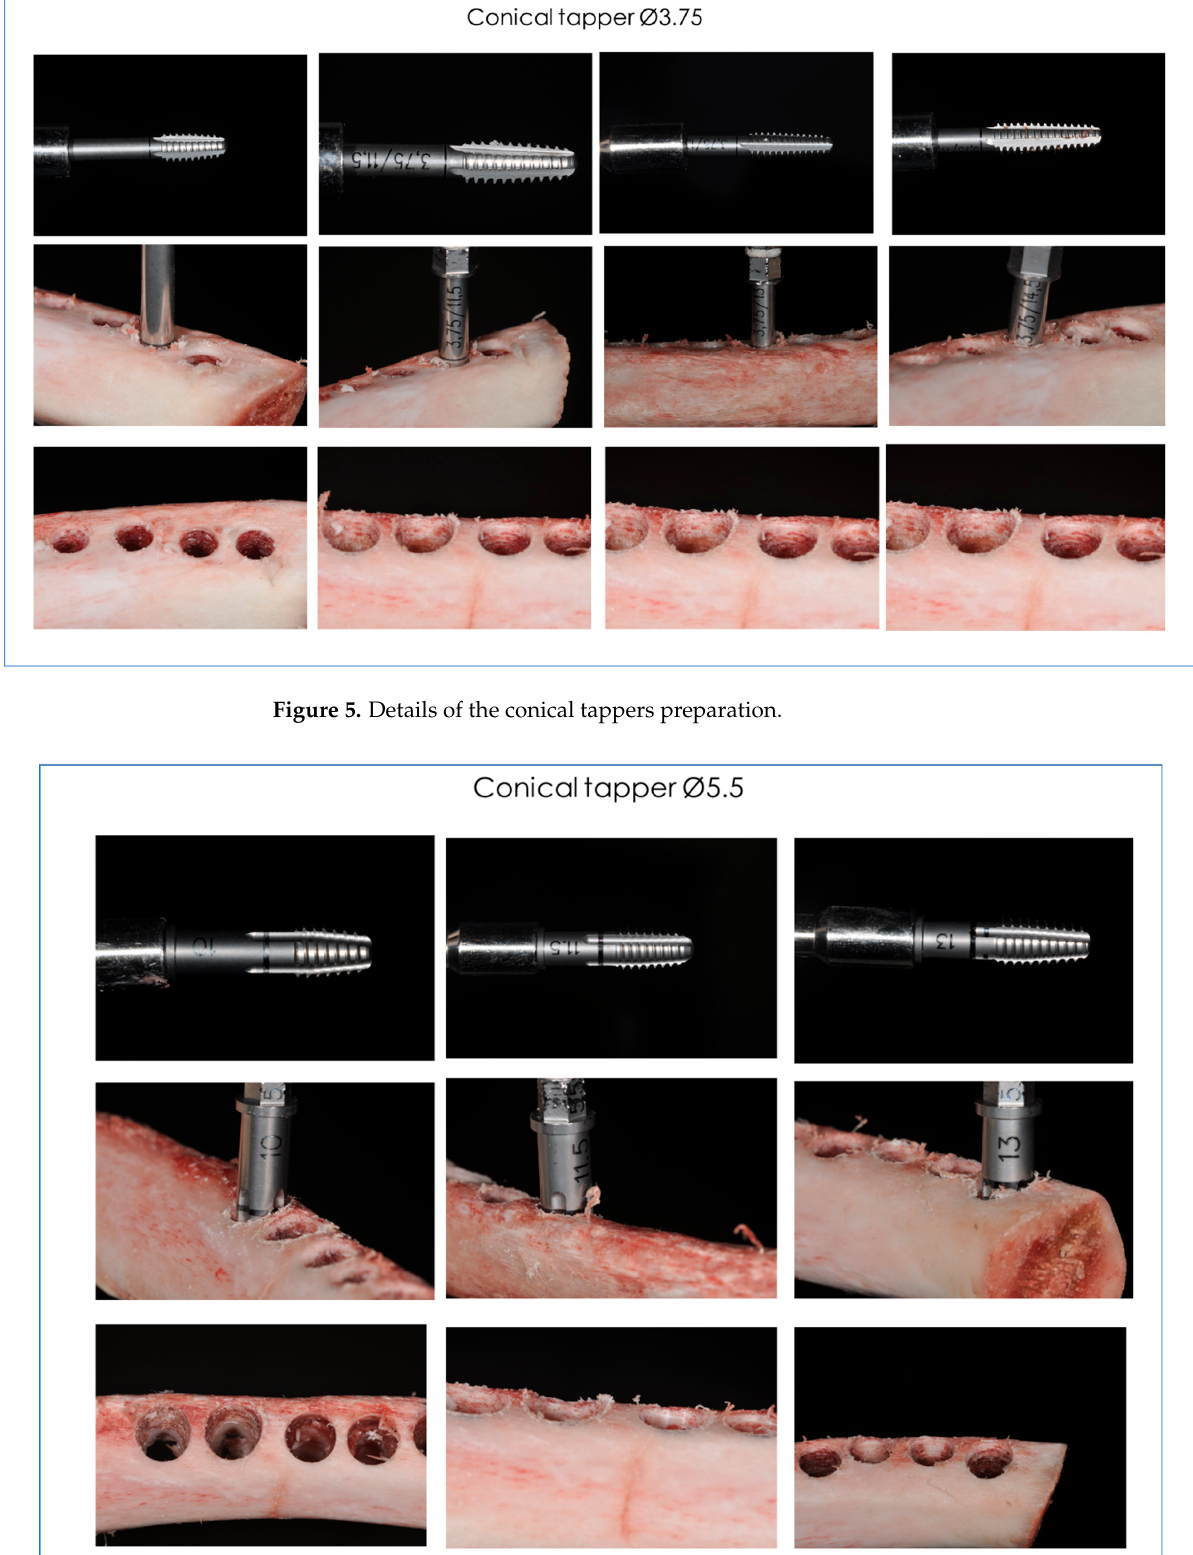
Figure 6. Details of the conical tappers (continued)